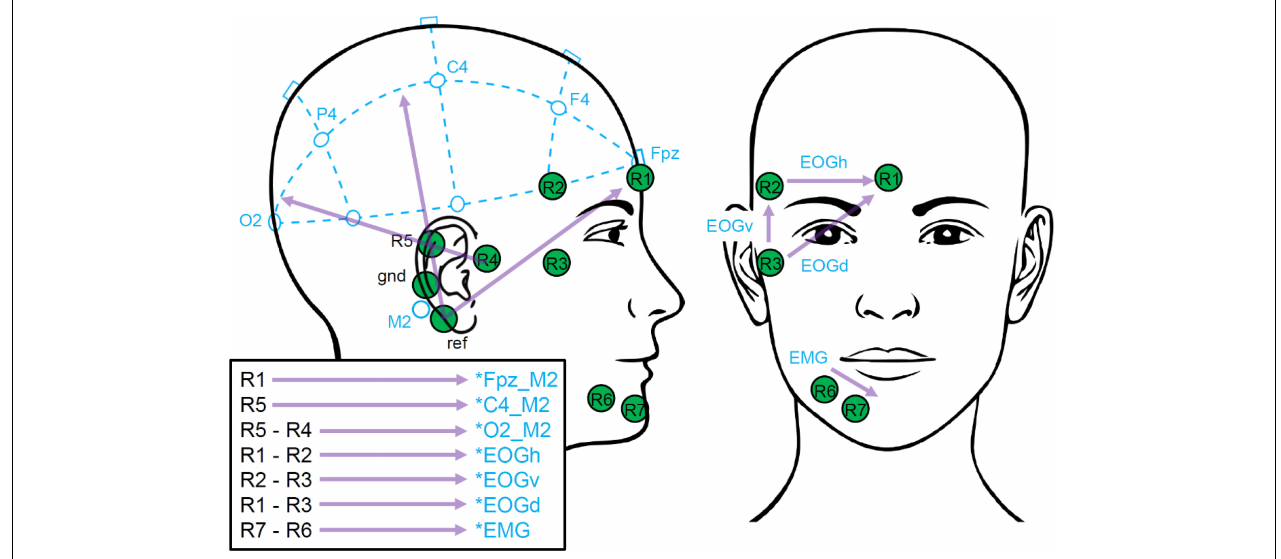
FIGURE 3 | trEEGrid channel combinations. These bipolar channels extrapolate toward classical PSG scalp positions (Fpz, C4, O2) as well as EOG and EMG, as